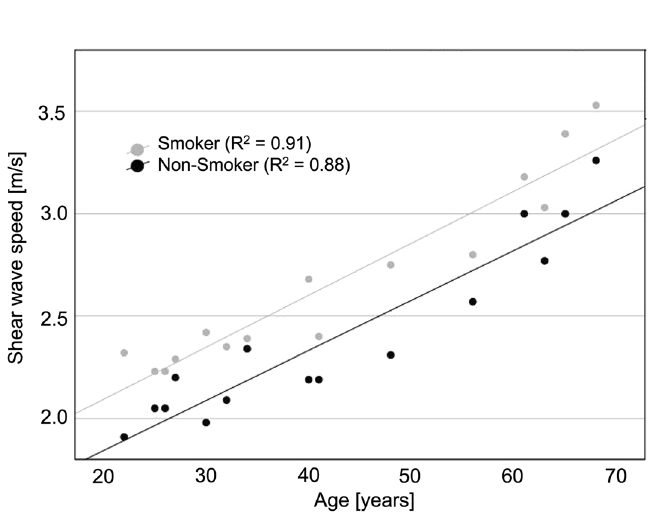
Figure 2. Scatter plot of shear wave speed versus age in smokers and non-smokers. Smokers (light gray dots) show a higher SWS (in meters per second) compared to age matched non-smokers (black